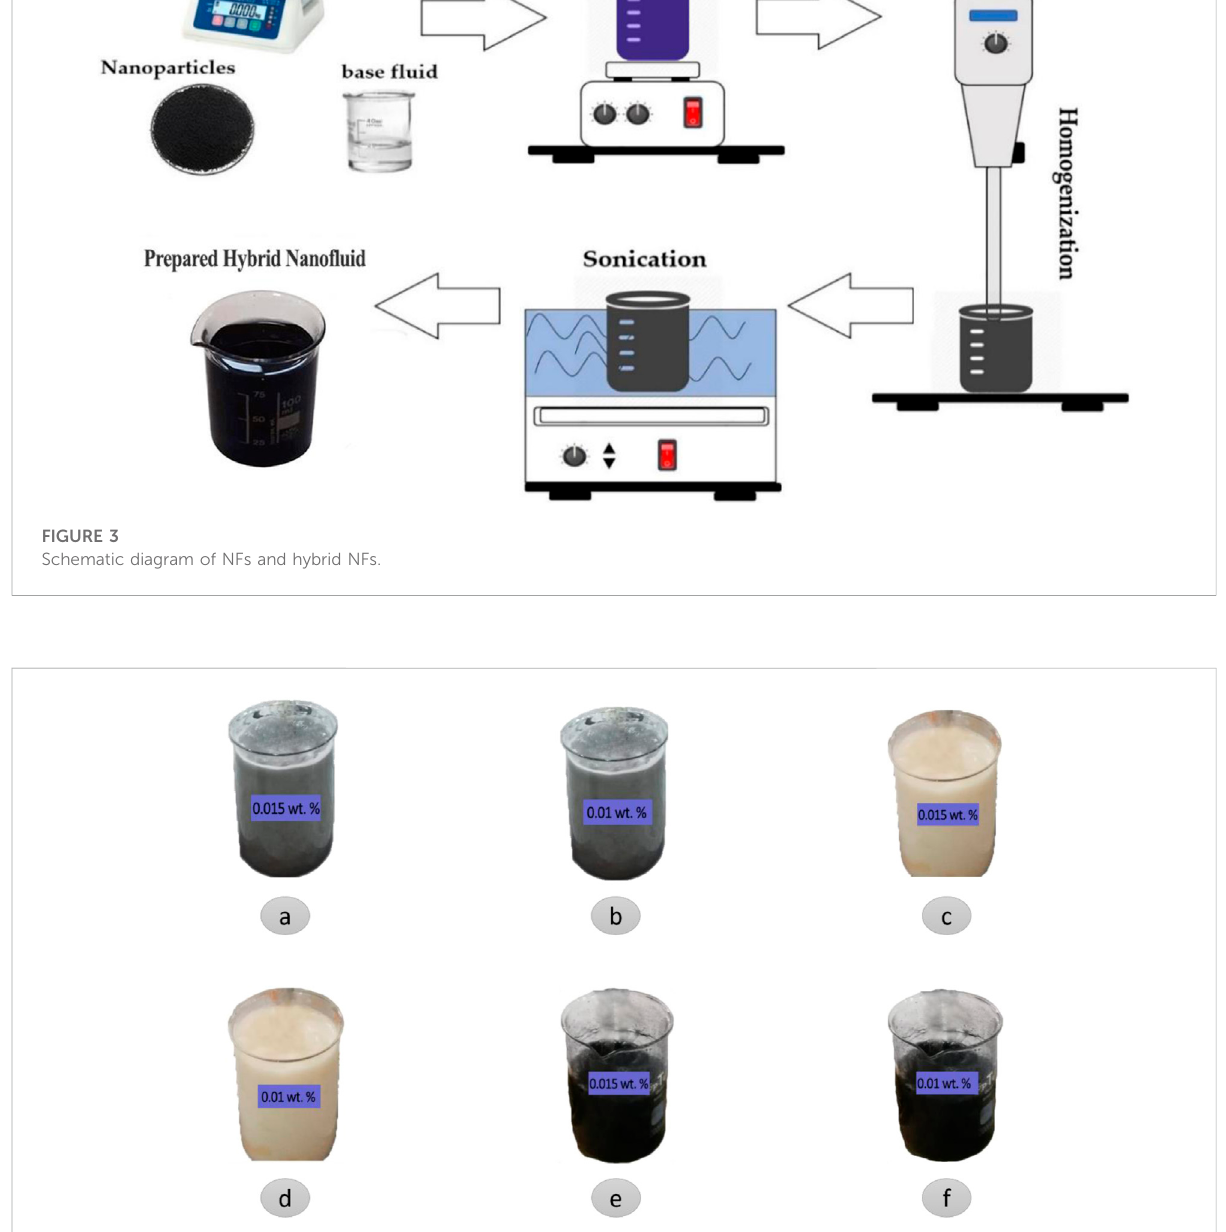
0.015 wt%) of NFs and hybrid NFs were examined. The experimentation was done in October – November 2020. The time for experimentation was 10:00 a.m. to 3:00 p.m. on a daily